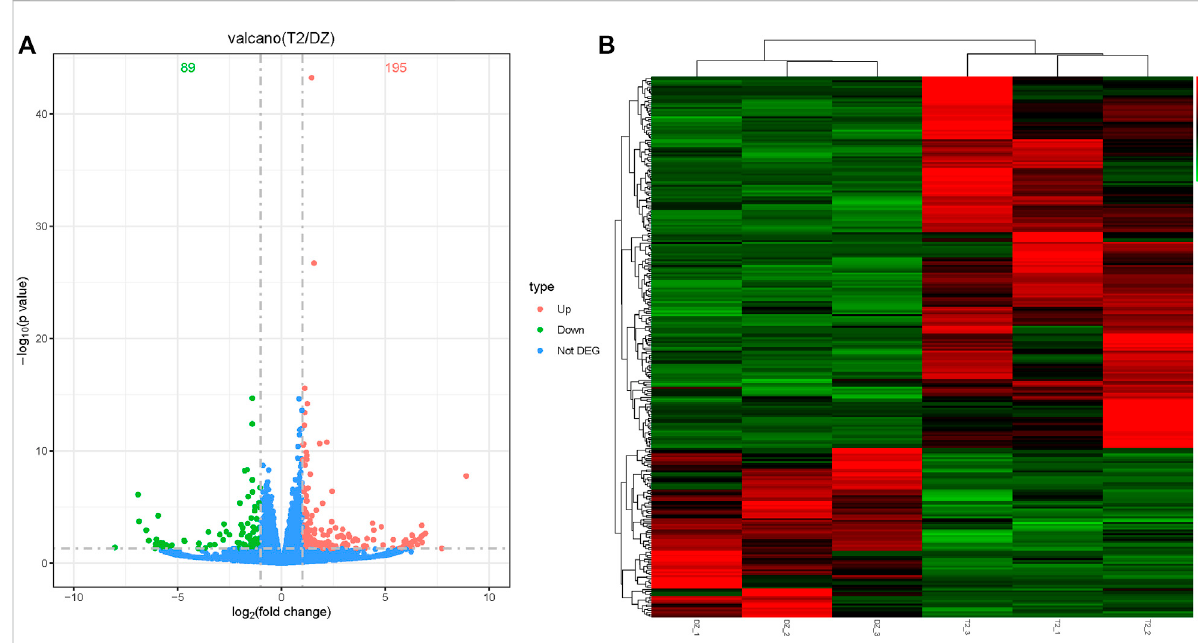
FIGURE 2 DifferentiallyexpressedmRNAanalysisandclusteranalysis. (A) VolcanoofdifferentiallyexpressedmRNAintheT-2toxingroupcomparedwiththe controlgroup.GreenrepresentsdownregulatedmRNA,andorangerepresentsupregulatedmRNA. (B) Hierarchicalclusteringofdifferentiallyexpressed mRNA in the T-2 toxin group compared with the control group. Green represents downregulated mRNA, and red represents upregulated